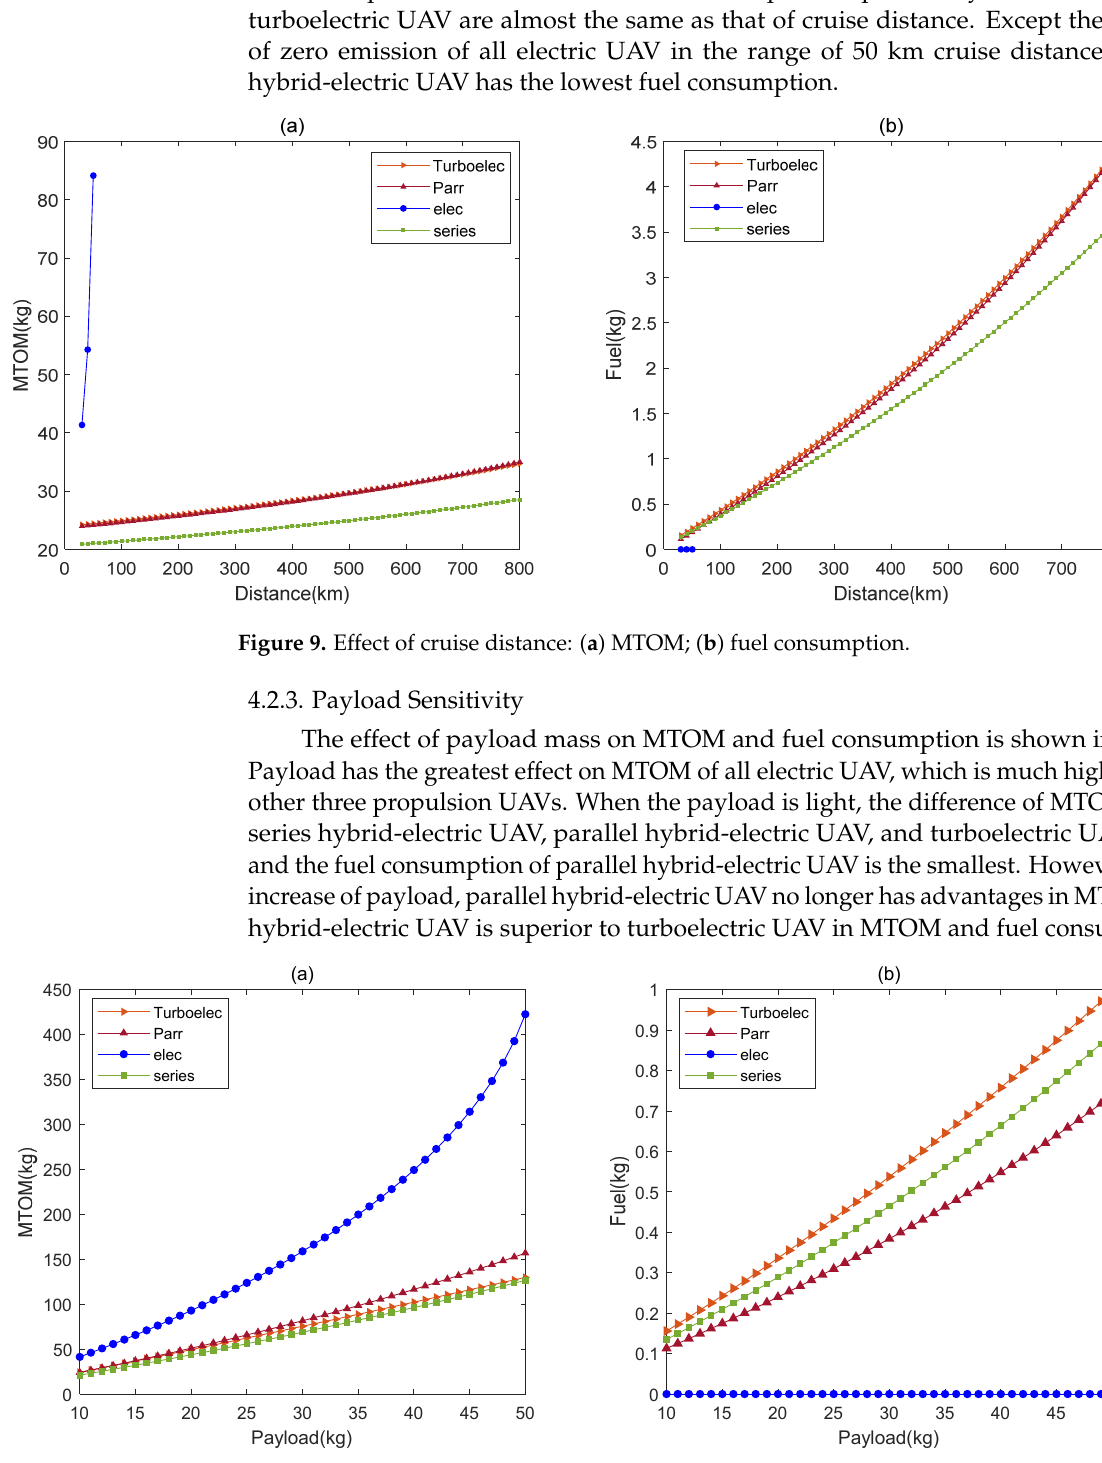
Figure 8. Effect of takeoff altitude: ( a ) MTOM; ( b ) fuel consumption.